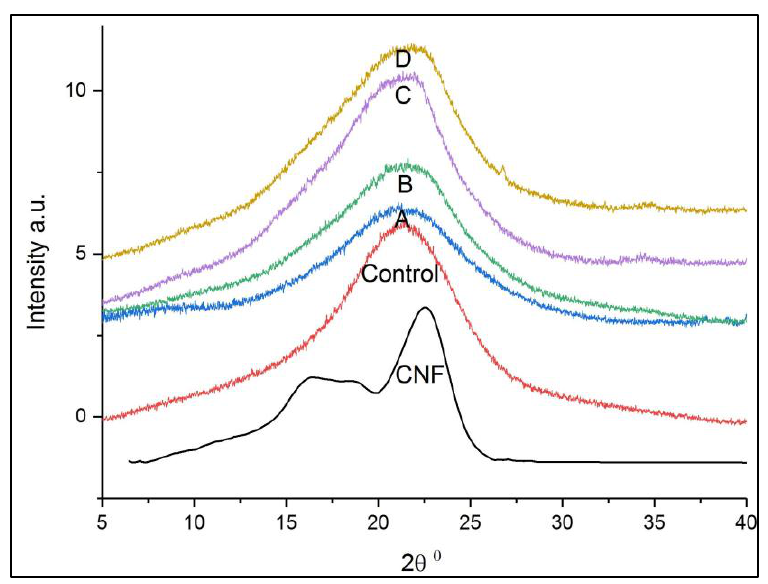
Figure 3 . XRD spectra of CNF, PUF control, and CNF-PUF with 10–40% CNF replacement ratios.